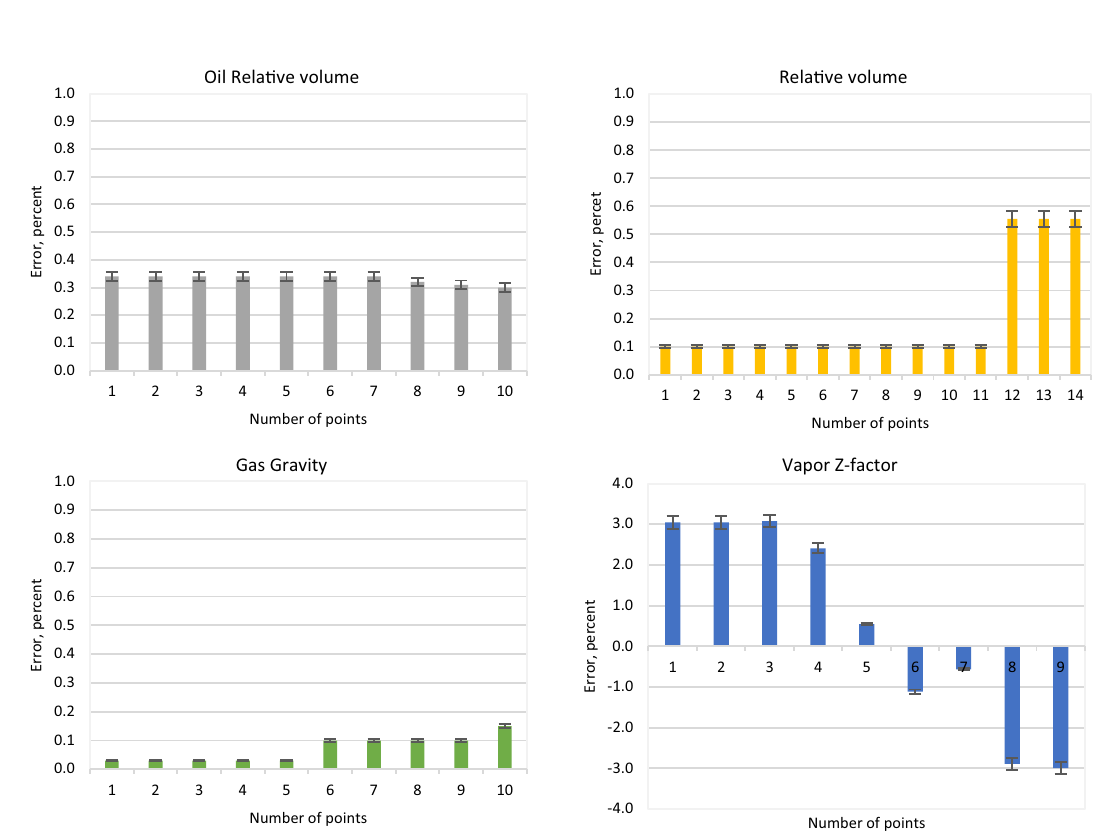
Fig. 2 Comparison between experimental and simulated PVT properties of oil: oil relative volume, relative volume, gas gravity, and gas z